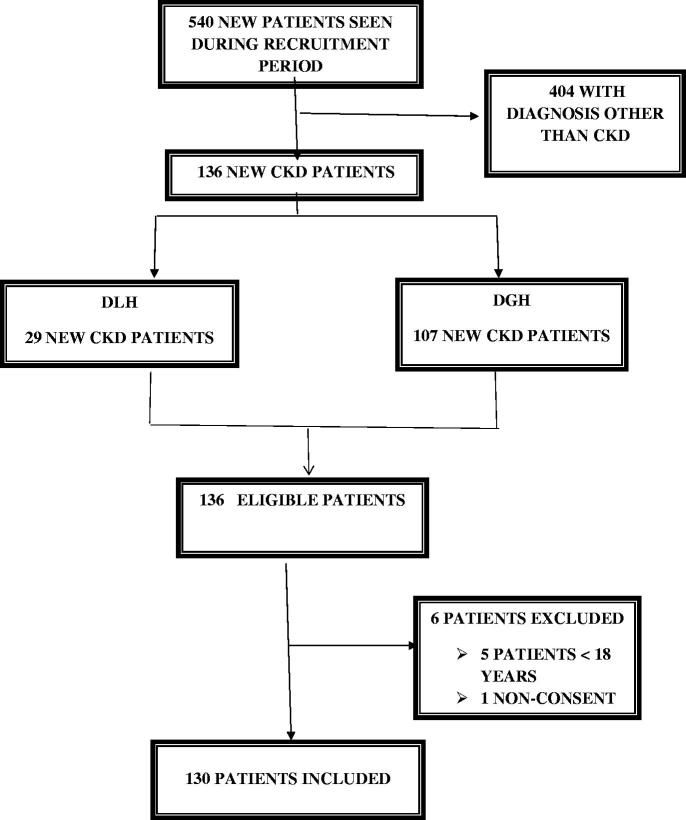
Flow chart representing the selection and inclusion of participants in the study.